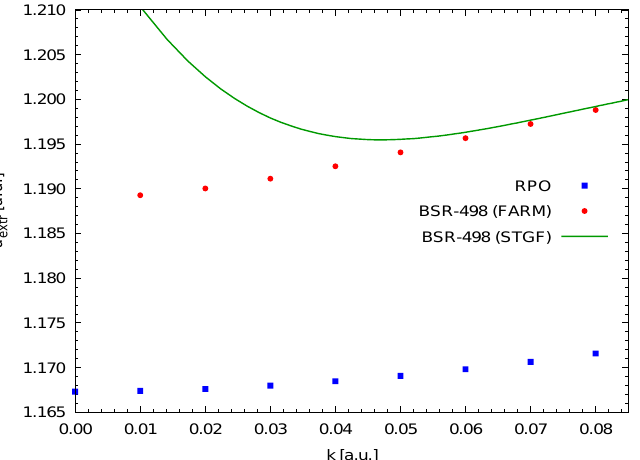
Figure 1. Extraction of the scattering length. Due to the limitations of the asymptotic FARM and STGF codes (see text for details), the smallest k -value in the BSR-498 calculation is 0.01, while the RPO code allows the calculation at zero collision